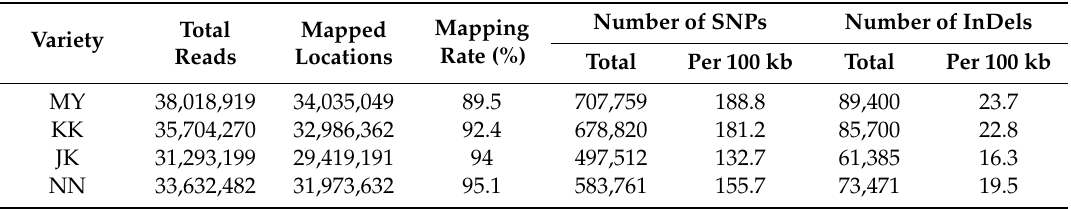
Table 2. Number of sequenced reads and frequency of single-nucleotide polymorphisms (SNPs) and insertions / deletions (InDels) detected in all rice